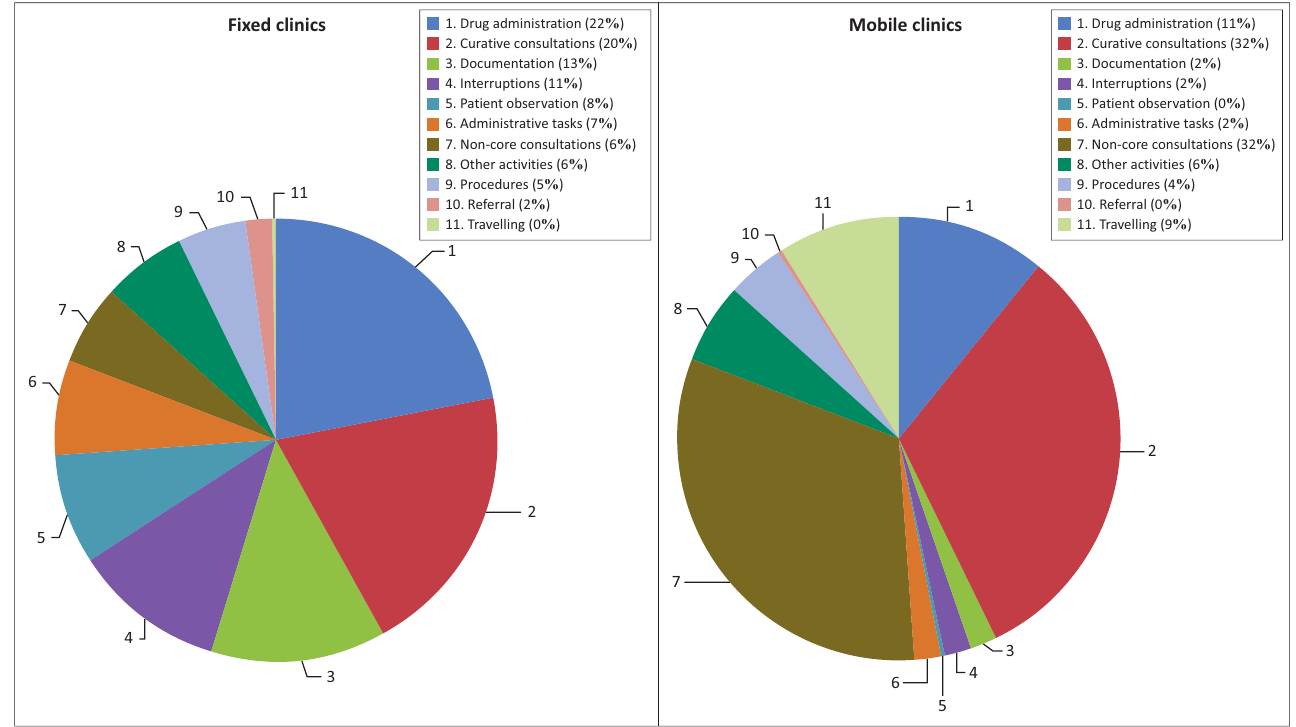
FIGURE 1: Breakdown of activities. TABLE 2: Frequency of specific non-core function consultations in fixed clinics and mobile clinics. Consultation